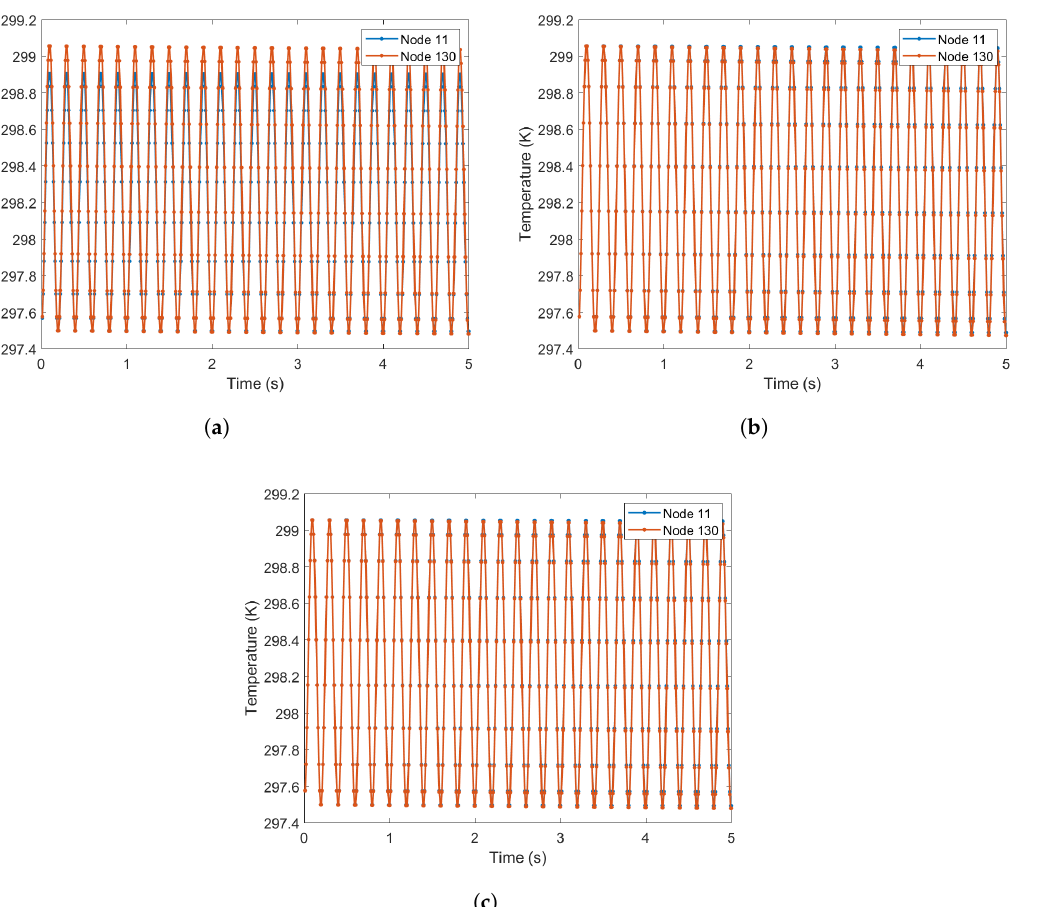
Figure 12. Temperature variation with time in the specimen for various values of elastic properties and f = 5 Hz. ( a ) E x = 10 GPa. ( b ) E x = 70 GPa. ( c ) E x = 300